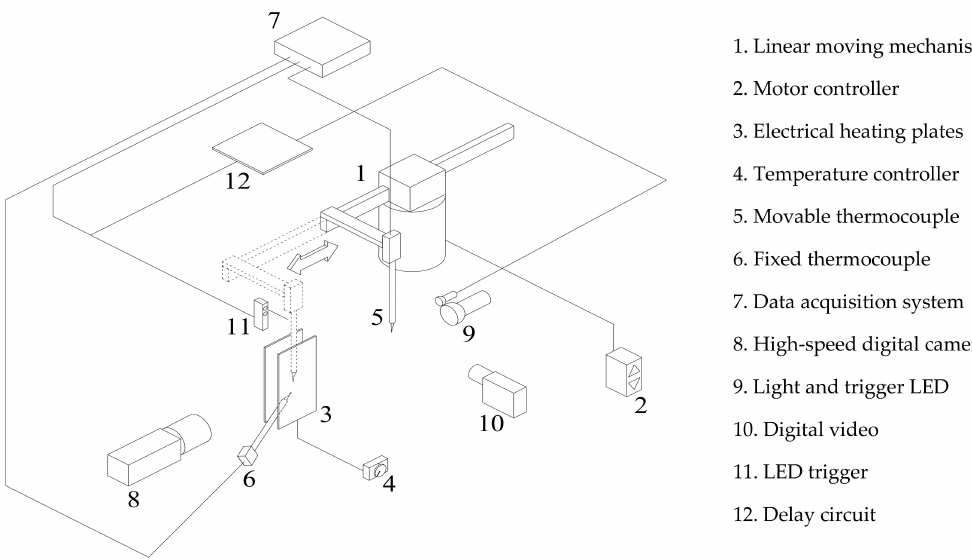
Figure 1. The experimental setup for the heating of the suspended